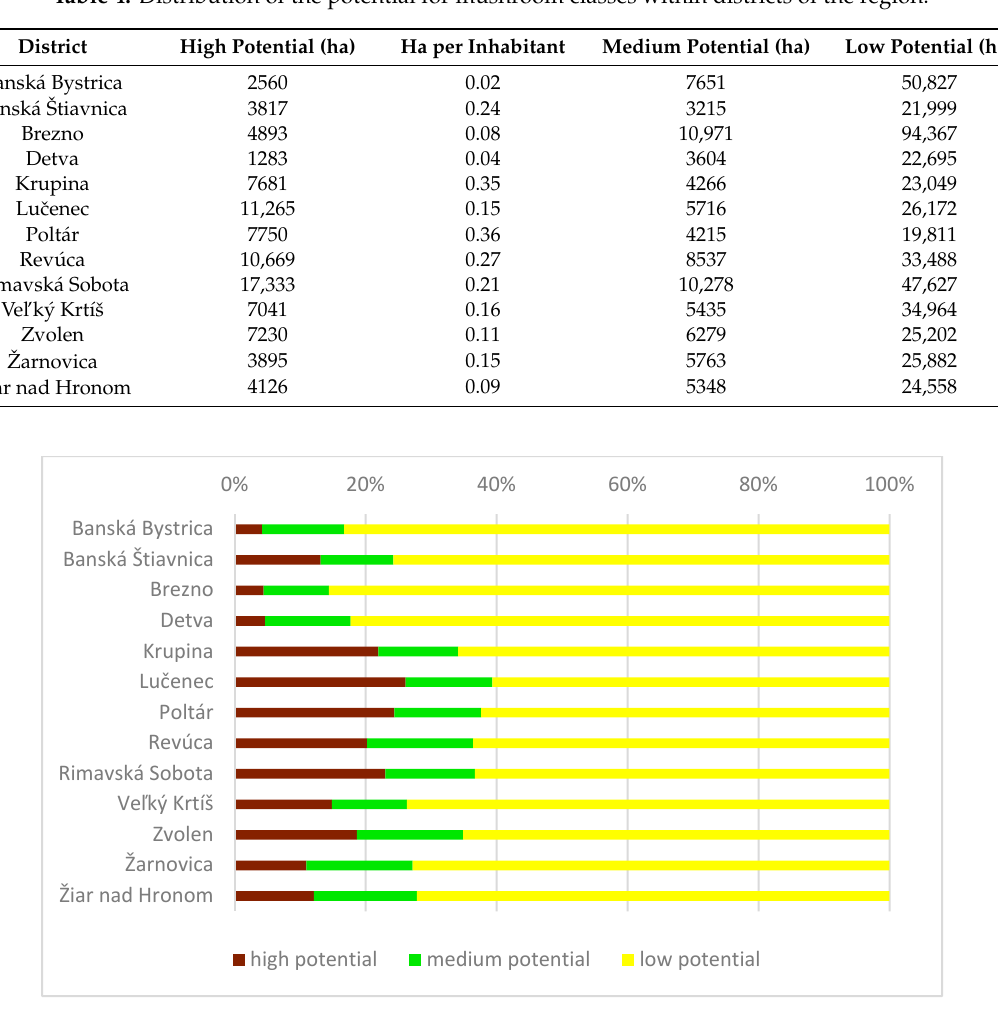
Figure 4. Occurrence of the potential for mushrooms within distance zones from the settlements. 4. Discussion 4.1. Modelling and Parameters The method applied for assessing the potential for ectomycorrhizal mushrooms in the study area was based on the set of variables on a site’s natural conditions and forest stand’s structure and the available national Forest Inventory database. The main advantage of this database is that it is a mandatory database for all forests in the Slovak Republic serving as the basis for Forest Management Programs; therefore, it is updated every ten years following uniformed structure and quality. This means that the presented method can be rather easily applied for the whole country in case there is a demand for such an analysis. In addition, the applied calculus is rather simple and enables the addition of more variables if needed. Since it is based on multicriteria analysis, it is also compatible with the multicriteria decision analysis method applied in land management studies such as land suitability evaluation [49], land management [50], or flood risk assessment [51]. It is also applied in